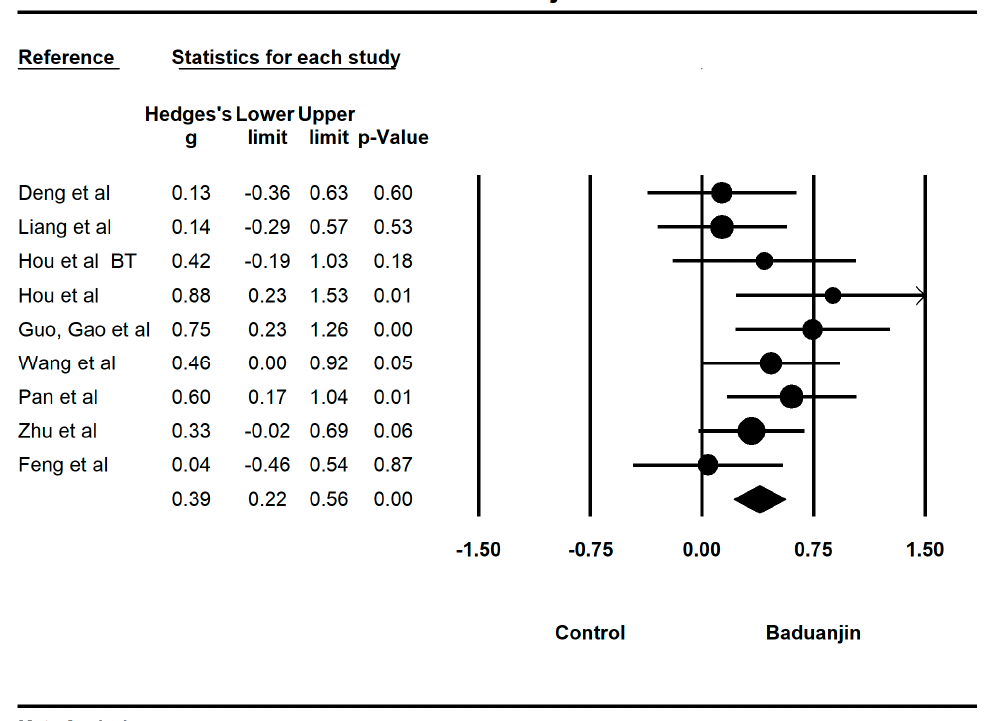
Figure 9. Effects of Baduanjin on FVC (BT = breathing technique training).